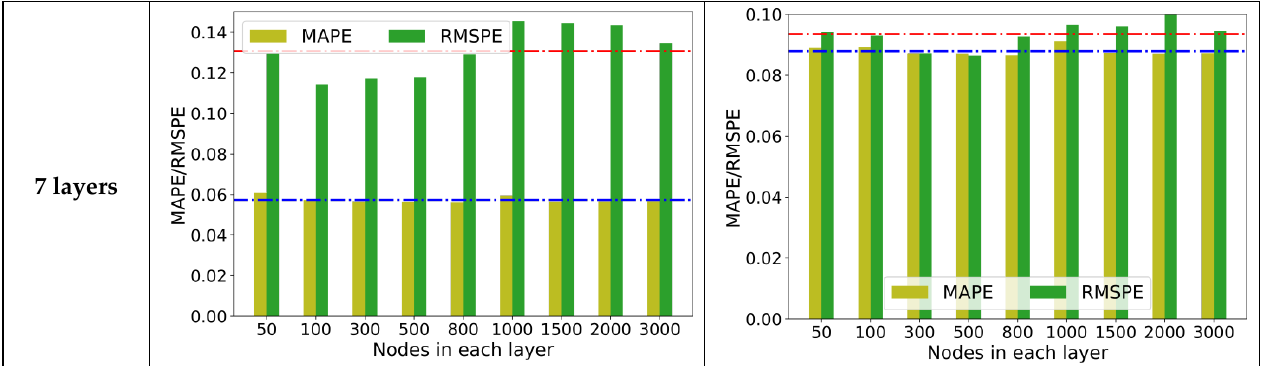
Figure 9. Model performance MAPE/RMSPE of models with different layers and nodes.